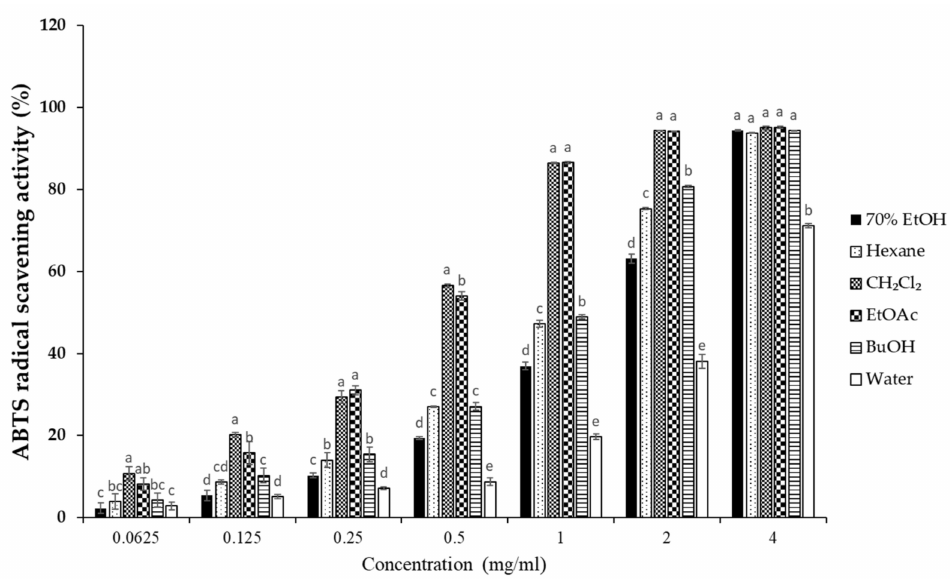
Figure 4. Effects of S. horneri extract and its fractions on ABTS radical scavenging activity. The measurement of ABTS radical scavenging activity is described in the Materials and Methods section. All data represent mean values of 3 independent experiments ± SD. Data were statistically considered at p < 0.05, and different letters (a–e) in graph represent statistical